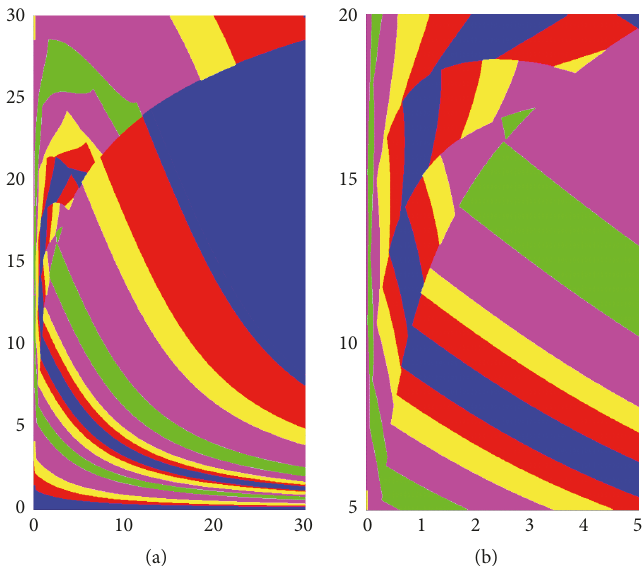
Figure 10: Basin of several attractions shown in Figure 9. The red, magenta, blue, and green points are attracted to the attractor shown in Figure 9 from top to bottom, respectively. The yellow points represent the other attractors not shown in Figure 9. All the parameters are identical to Figure 9. (b) is the magnification part of